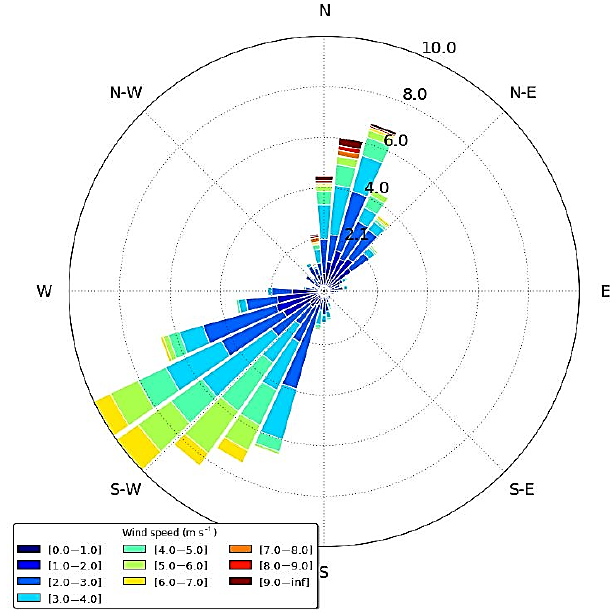
Figure 4. Hourly wind rose diagram of Abidjan during the dry sea- son (15 December 2015–16 February